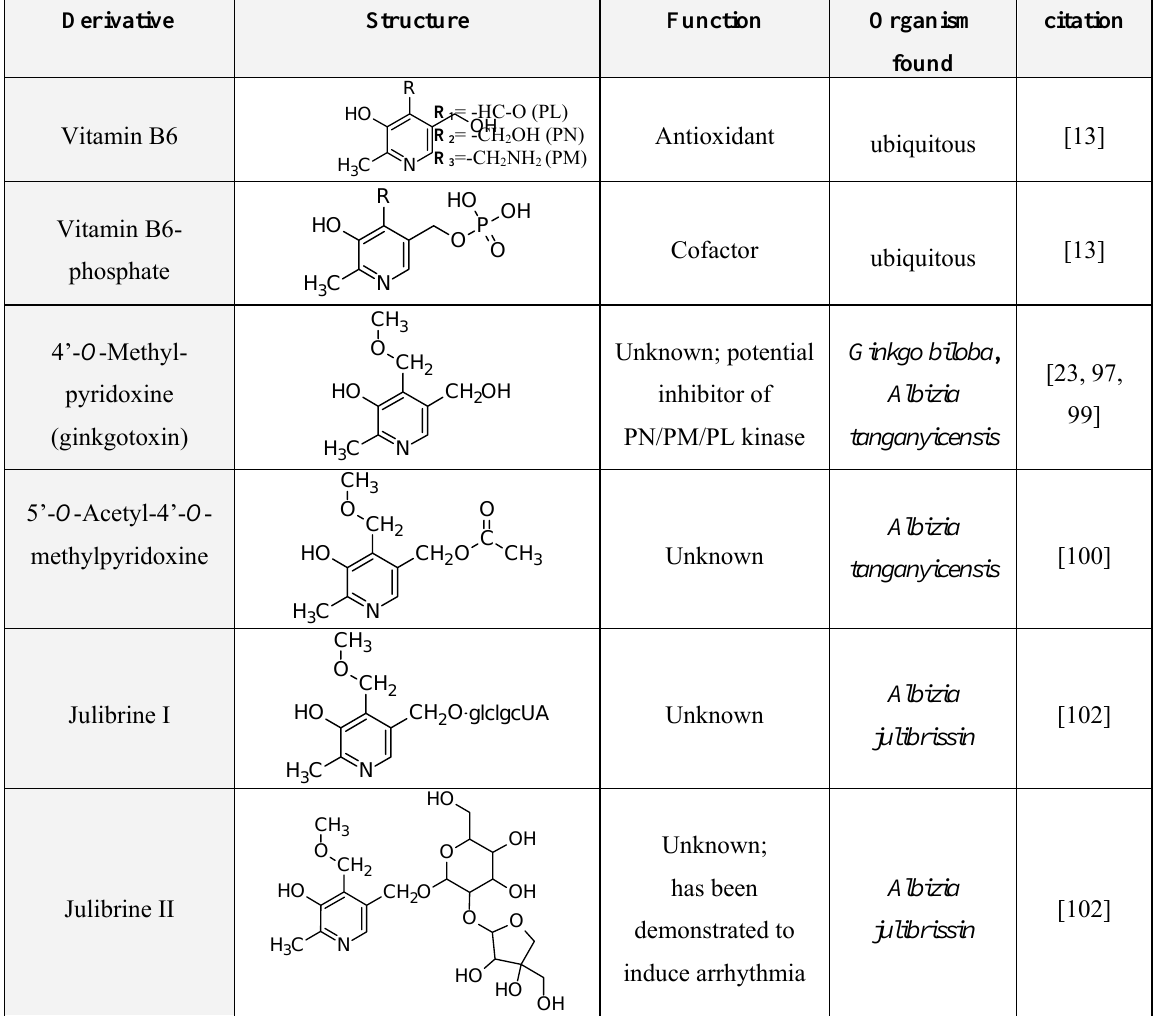
Table 2 . Examples of VitB6 Vitamers and Their Derivatives